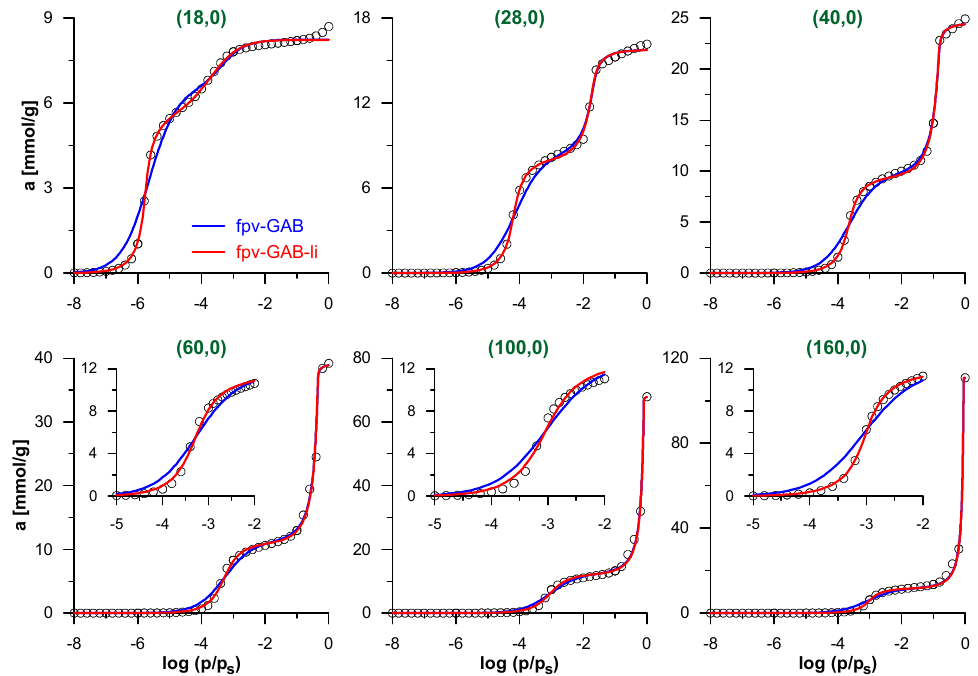
Figure 2. Simulated isotherms of N 2 adsorption inside selected carbon nanotubes (CNTs) (points) and their fits by the models: fpv-GAB (Equations (4)–(8))—blue lines and fpv-GAB-li (Equations (5), (6) and (8)–(10))—red lines. Only selected simulated points are shown for clarity. The inserts in lower panels show the low-pressure part of isotherms, related to the formation of N 2 monolayer on the pore wall.